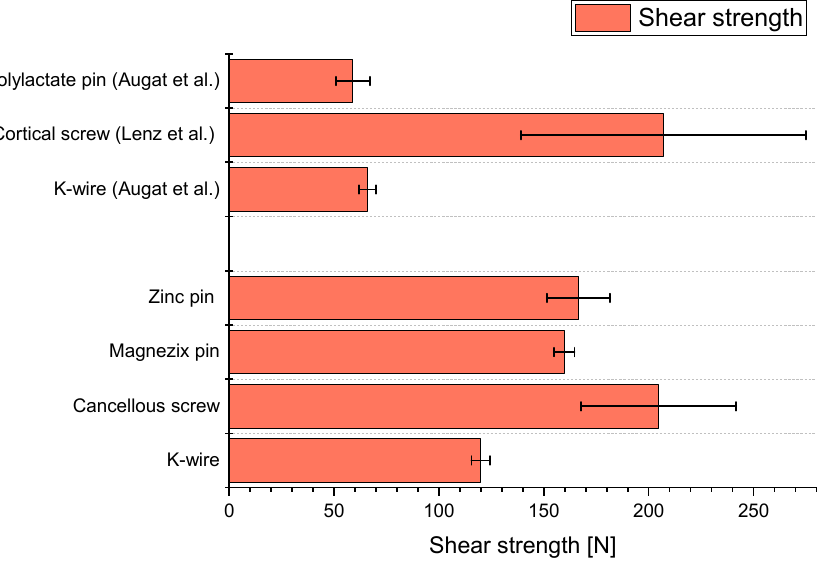
Figure 4. Average maximum shear strengths of the implants measured in this study in comparison to the literature by Augat et al. [5] and Lenz et al. [44] (both with n = 6).